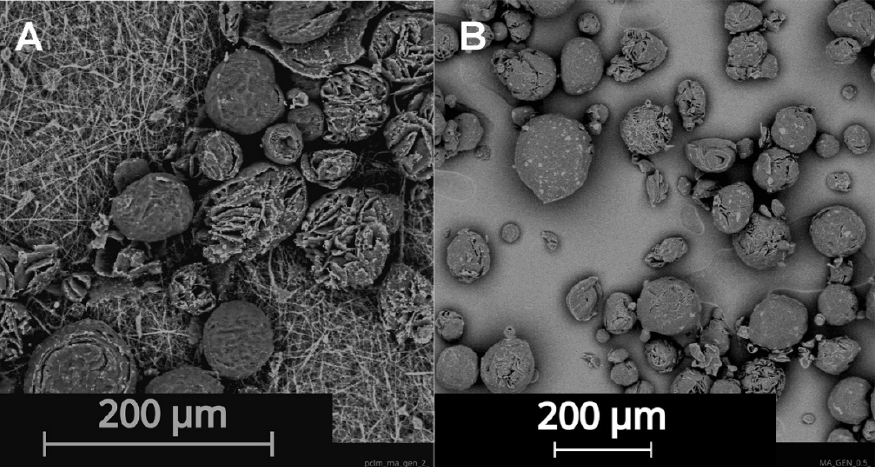
Figure 3. Structure of SLP placed ( A ) on nanofiber substrate PCL_AA ( B ) on tissue culture plate. SEM analysis.